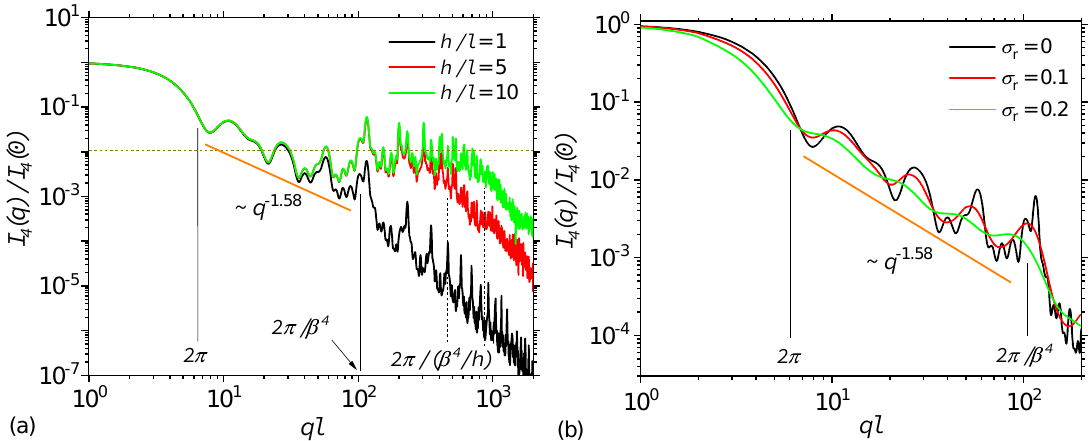
Figure 4. Form factor of ST at m = 4. ( a ) Monodispere curves, with various values of the ratio h / l of the distances between triangles to their size. ( b ) Polydisperse curves, with various values of the relative variance σ r . l is the overall size of the ST, and β = 1/2 is the scaling